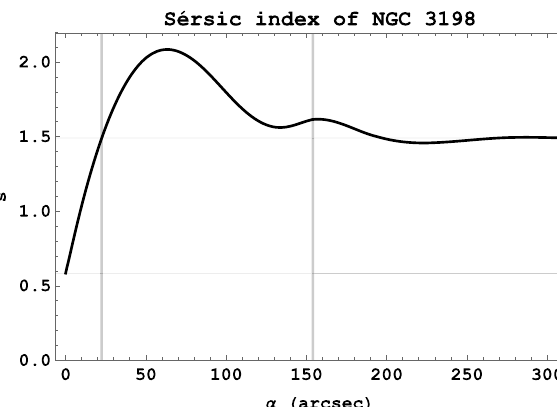
experimental values listed by Begeman [11], represented by dots. The vertical lines in both graphics indicate the central positions of the spiral arms. The mass density profile extends to the last measurement taken at l ρ = 14 . 1 kpc. The last measured value of the rotation velocity lies at l β = 29 .